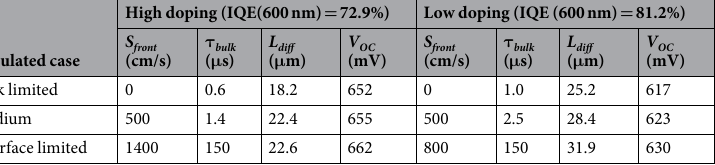
Table 4. Overview over simulated cells with same IQE at 600 nm as best IBC cells on high and low doping absorbers. Three cases were simulated: bulk limited, interface limited, and one intermediate case. S front , τ bulk input parameters are listed with their respective resulting L diff